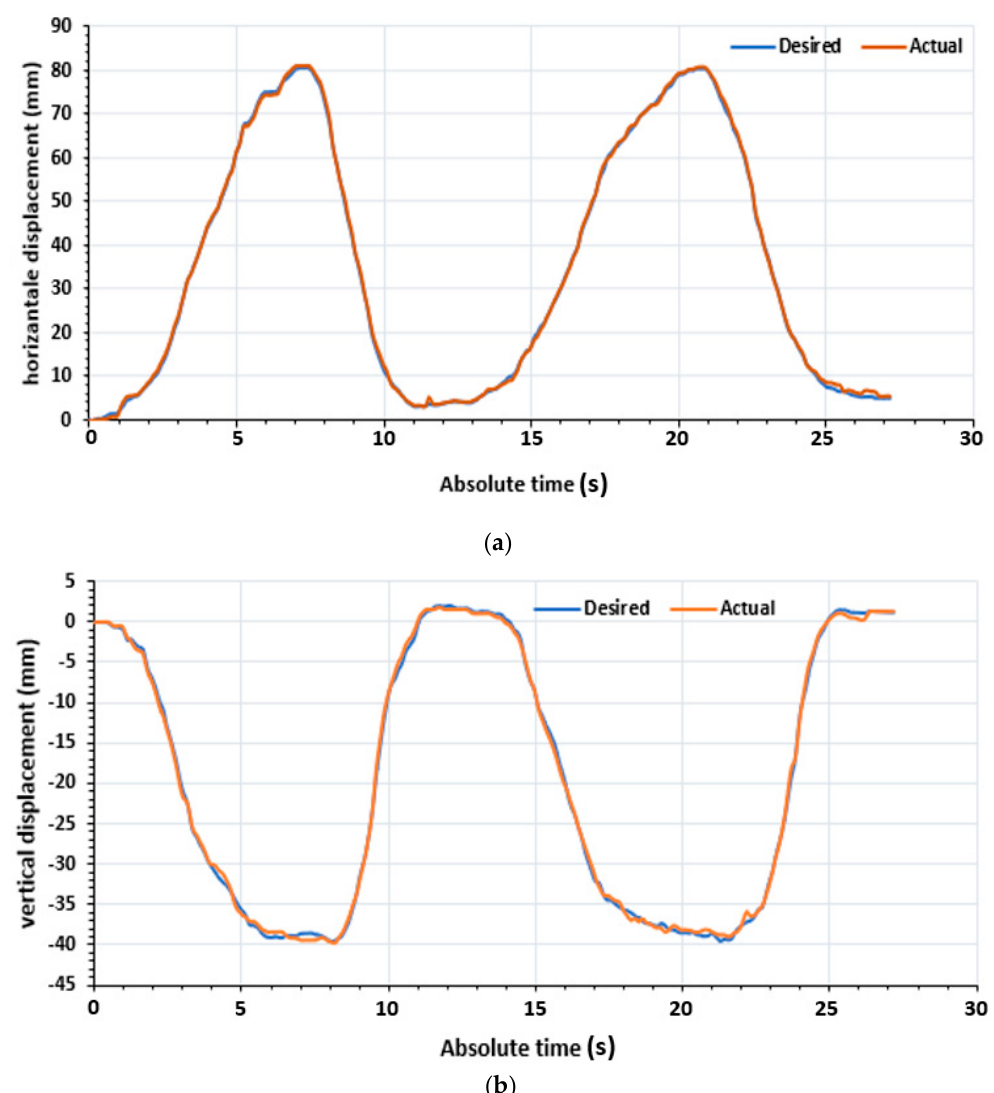
Figure 12. Continuous passive motion rehabilitation experiment of s typical finger DIP flexion and extension joint displacement;( a ), horizontal displacement; ( b ), vertical displacement.